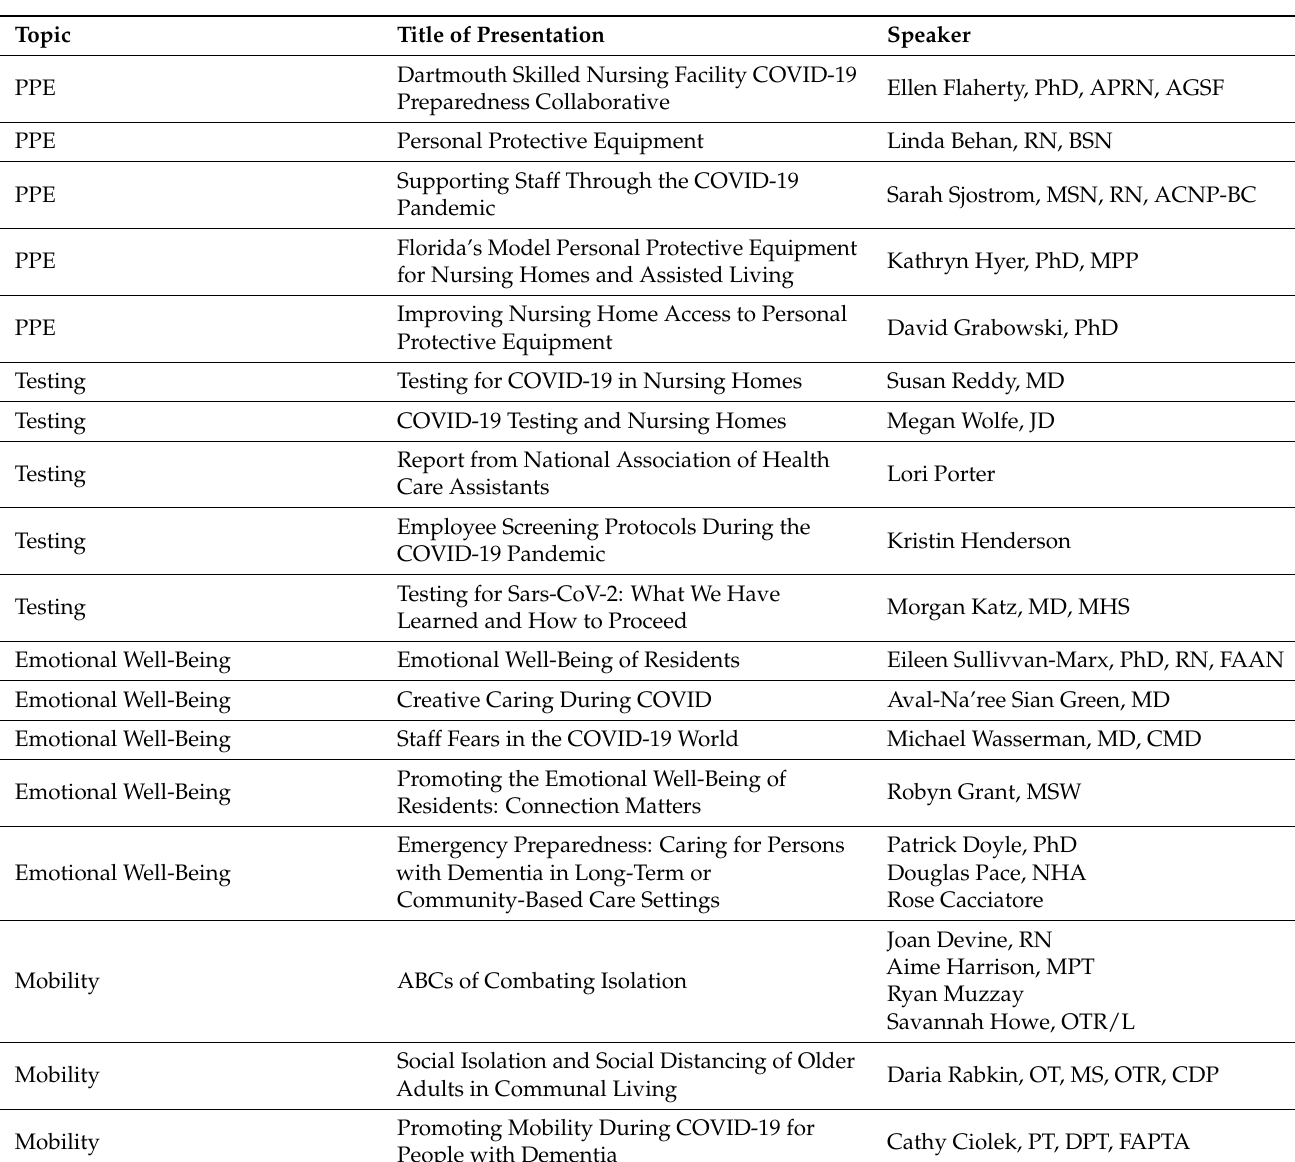
Table A1. List of all speakers, presentations, and topics during the